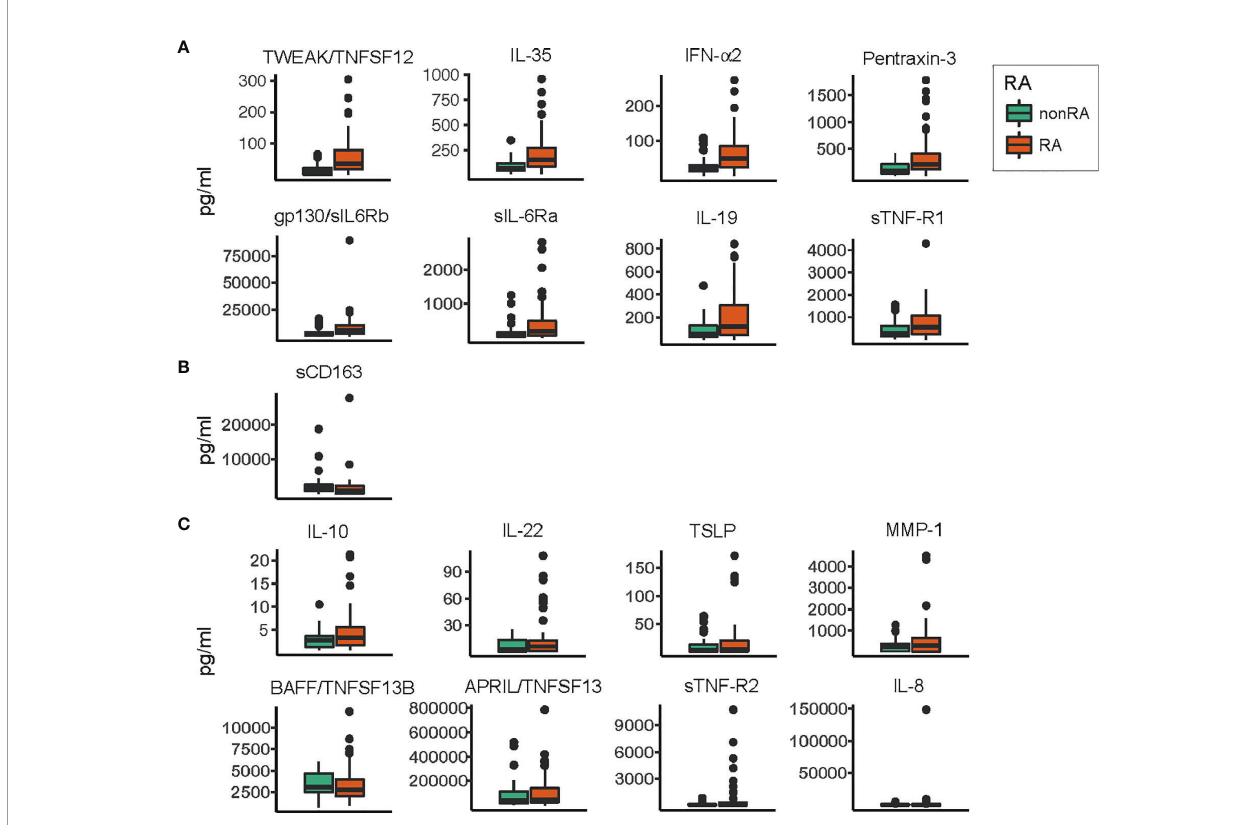
FIGURE 3 | Levels of in fl ammatory mediators/cytokines in saliva samples from patients with and without RA. Box plots describing the levels of in fl ammatory mediators in saliva samples from periodontitis patients with RA and saliva samples from non-RA patients with periodontitis. Orange boxes represent the group of periodontitis patients with RA, and green boxes represent the group without RA. (A) In fl ammatory mediators signi fi cantly (FDR adjusted p<0.05) enriched in saliva samples from patients with RA compared to non-RA patients. (B) The levels of soluble cluster of differentiation 163 (sCD163), the only in fl ammatory mediator signi fi cantly (FDR adjusted p<0.05) depleted in saliva samples from patients with RA compared to patients without RA. (C) In fl ammatory mediators whose levels did not differ signi fi cantly between the two groups. All values are pg/ml, and within each group (A – C) the in fl ammatory mediators are ordered according to decreasing signi fi cance. TWEAK, tumor necrosis factor-like weak inducer of apoptosis; TNFSF12, tumor necrosis factor ligand superfamily member 12; IL, interleukin; IFN- a 2, interferon alpha 2; gp130, glycoprotein 130; sIL-6Rb, soluble IL-6 receptor b; sTNF-R1, soluble TNF receptor 1; TSLP, thymic stromal lymphopoietin; MMP-1, matrix metalloproteinase 1; BAFF, B-cell activating factor; APRIL, a proliferation-inducing